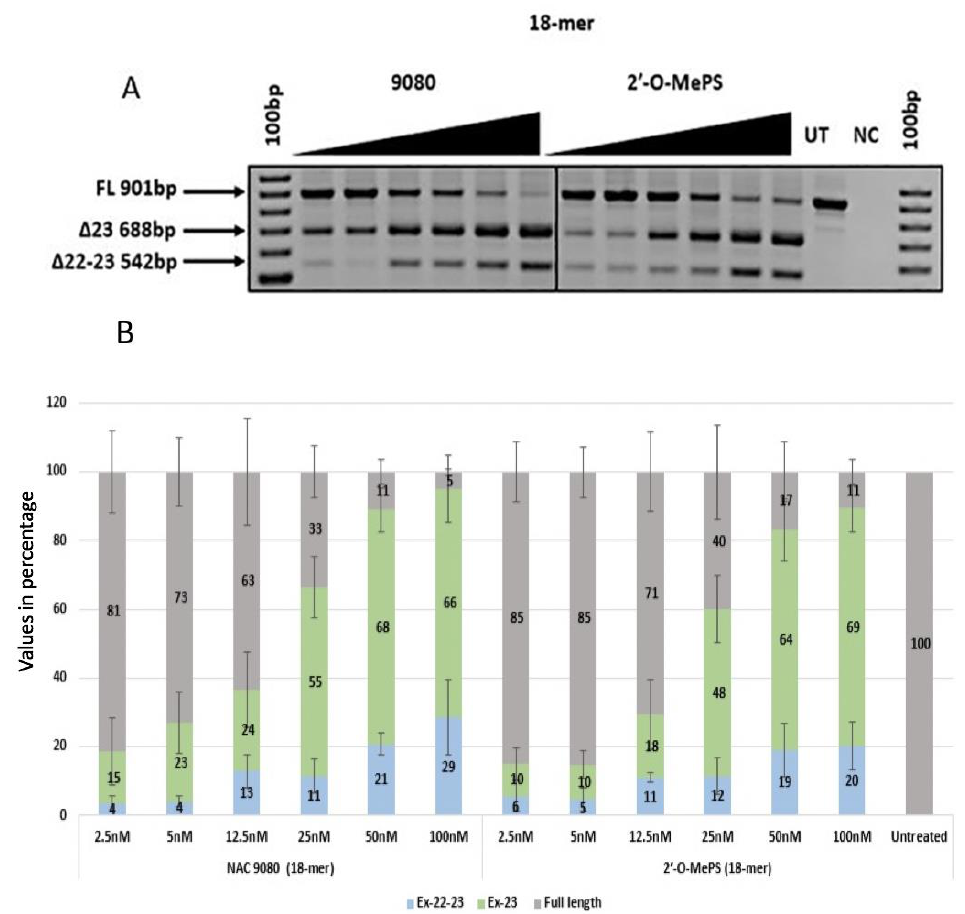
Figure 4. ( A ) RT-PCR analysis of exon-23 skipping induced by AO NAC 9080 and the corresponding 2′ -OMePS control AO in H2K mdx mouse myotubes (gel image A corresponds to one of the three gels used for data in ( B )); ( B ) densitometry analysis of exon-23 skipping induced by AO NAC 9080 and the corresponding 2′ -OMePS control AO (triplicates) in H2K mdx mouse myotubes. Concentration range 2.5–100 nM. Grey, full-length product exon 20–26; green, exon-23 skipped product; blue, dual exon 22 / 23 skipped product; UT, untreated; NC, negative control (Error bars represent the standard deviation of mean).